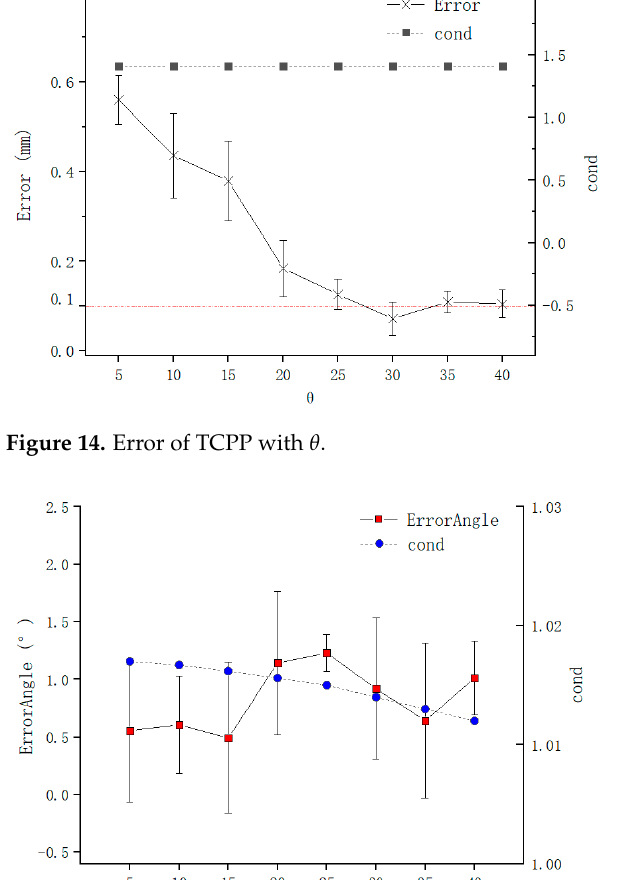
17 of 21 Figure 13. Error of TCPF with φ . The error of TCPP and TCPF are as shown in Figures 14 and 15, which are calculated